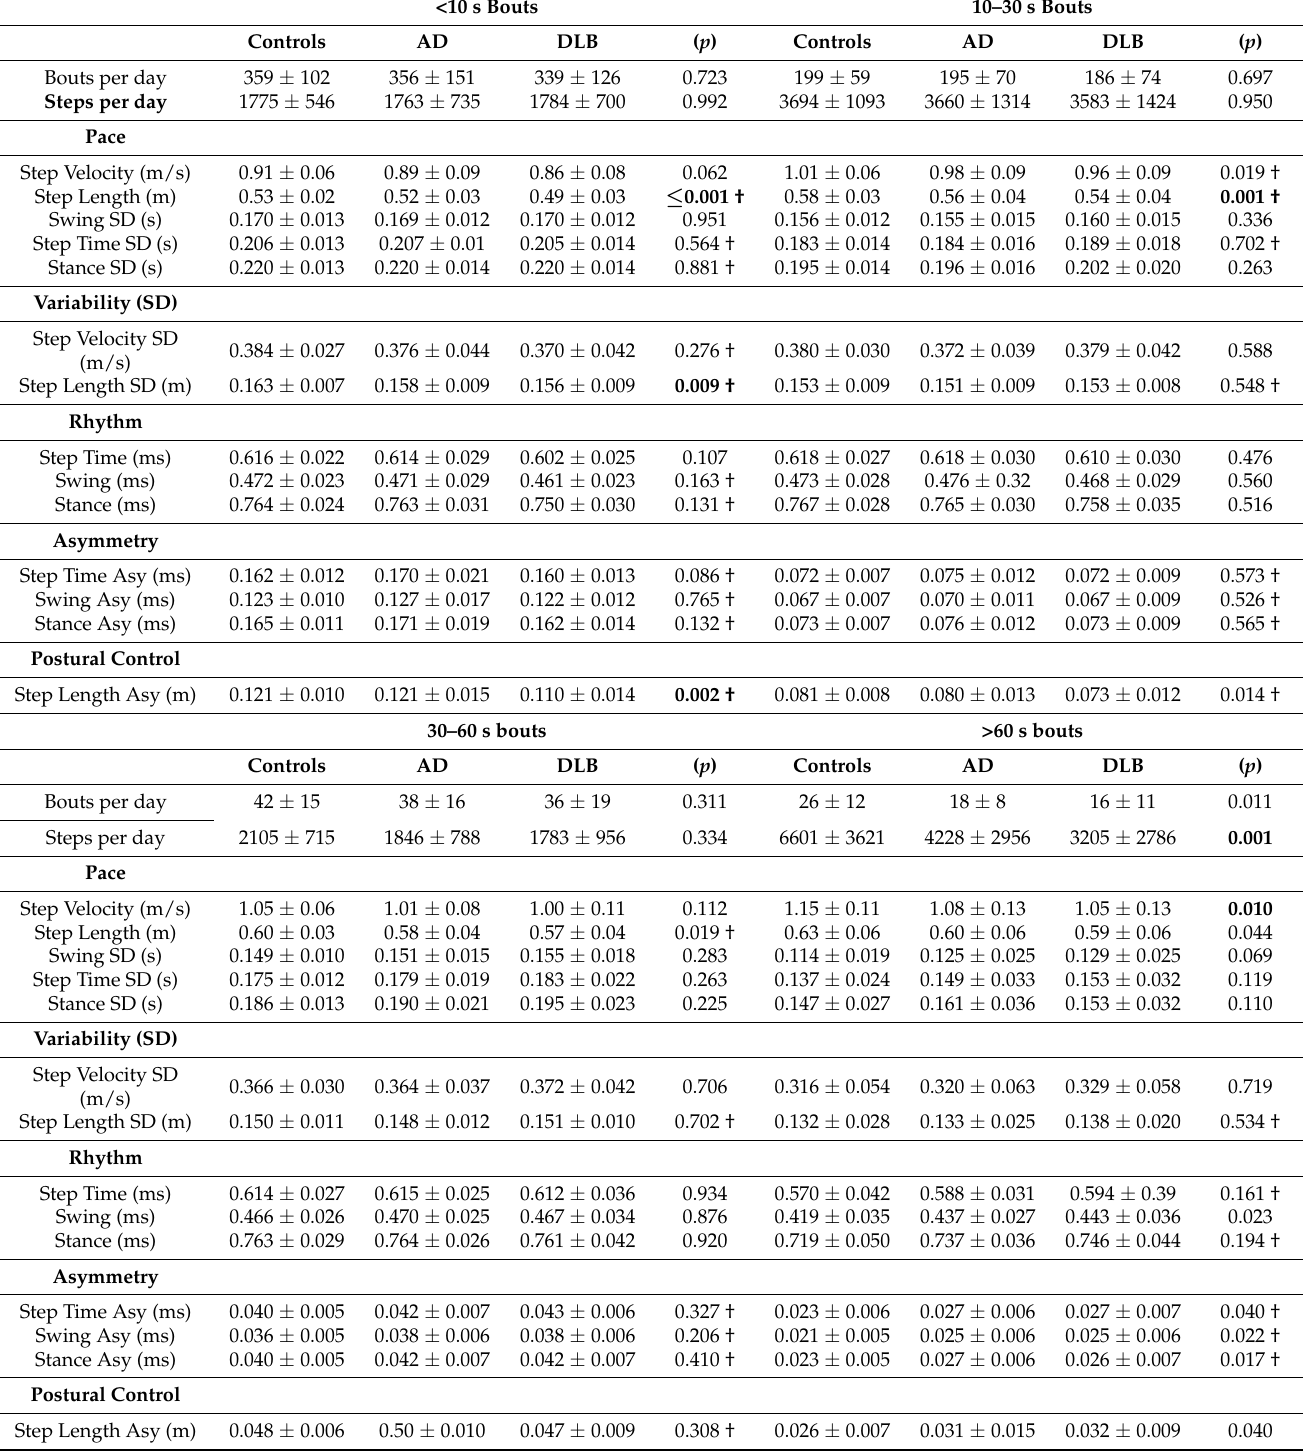
p value in table represents differences between all groups as reported from ANOVA/Kruskal Wallis tests. † indicates where results were determined from Kruskal Wallis tests. Statistical significance set at α = 0.01. Other abbreviations include: SD =within-person standard deviation (i.e., gait variability), asy = asymmetry, m = metre, s = second, ms =